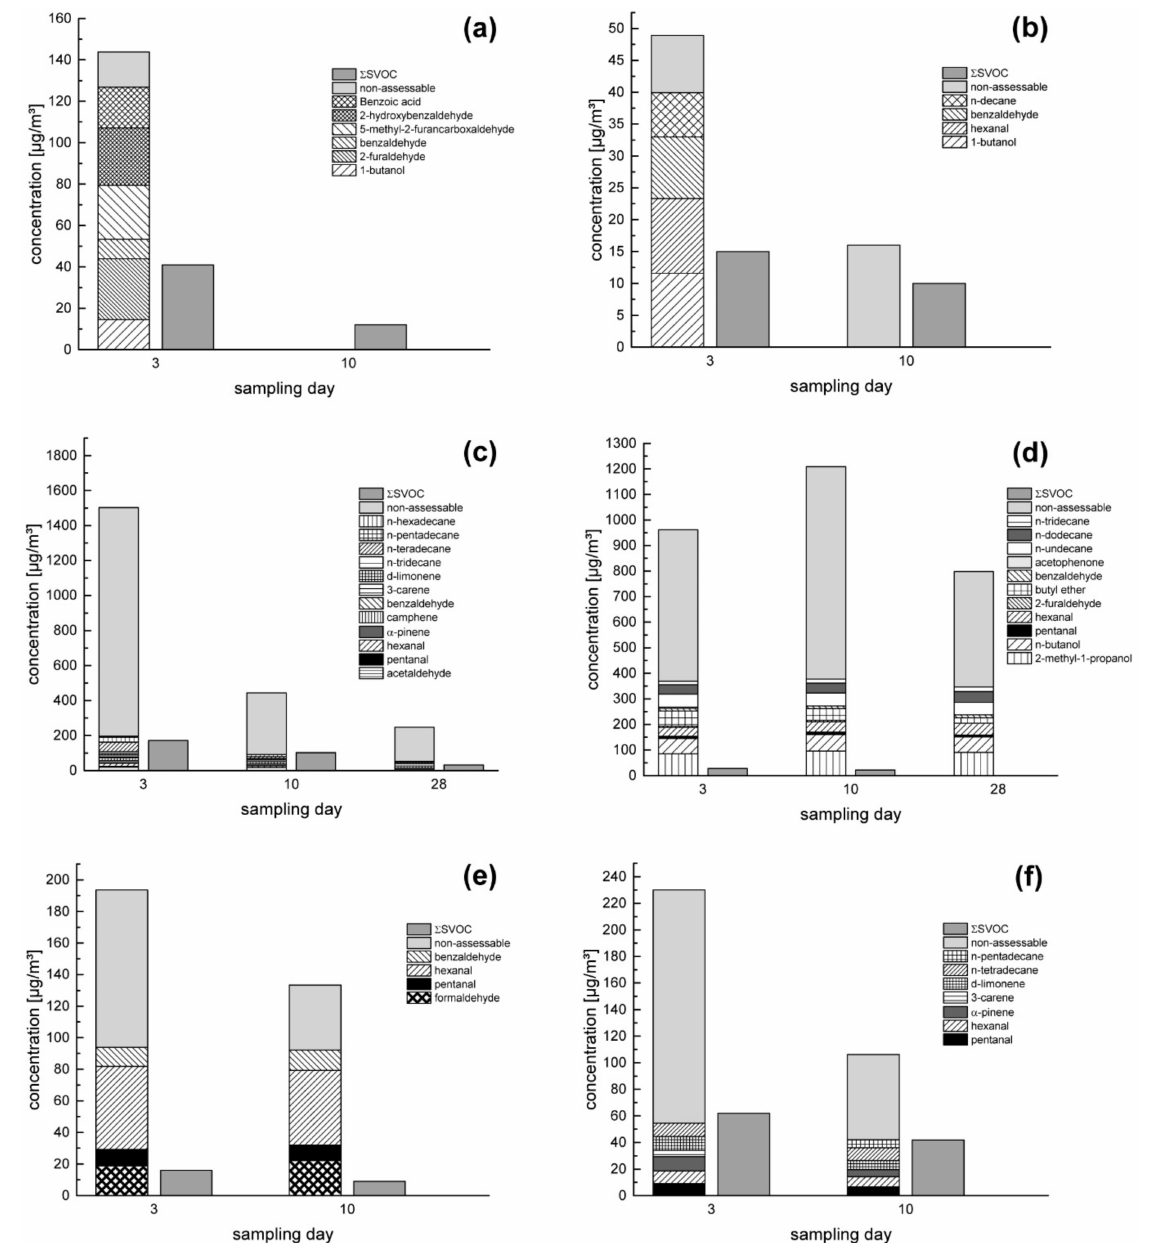
Figure 4. Measured volatile organic compounds (VOC) and sum parameter of semi-volatile organic compound ( Σ SVOC) concentrations of six selected samples showing single VOC concentrations: samples no. 7 ( a ), no. 8 ( b ), no.11 ( c ), no. 13 ( d ), no. 14 ( e ), no. 15 ( f